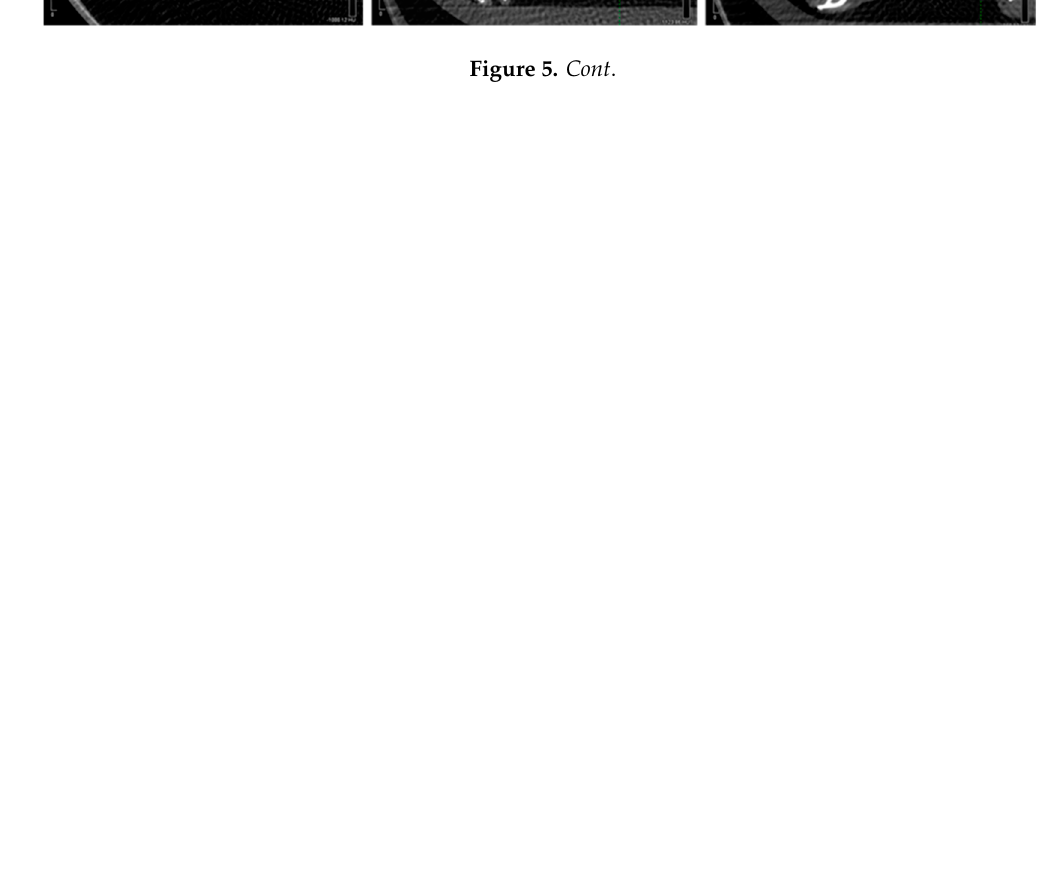
Figure 5. CD34 + cell implantation does not affect the bone formation rates in vivo. ( A ) Analysis of the bone formation over a period of 8 weeks from in vivo µCT (bone volume (BV) and bone mineral density (BMD)) depicting a transversal plane of a representative mouse. Blue arrows indicate the mouse femur and white arrows indicate the newly formed bone. ( B ) The bone volume (BV) of the scaffold reached a peak on week 2 and stabilised after week 4, indicating the formation of an organised cortical shell. After this time, the BV did not significantly change. On the other hand, the bone mineral density (BMD) of the scaffold increases with time, corroborating the organisation and growth of the bone organ. The BMD of the scaffold increased over time. The BV and BMD of the mouse femur were stable and tended to increase slightly, as per normal body growth. Lines in boxplot indicate the median, top and bottom lines corresponding to the 25% and 75% percentiles. The dots indicate